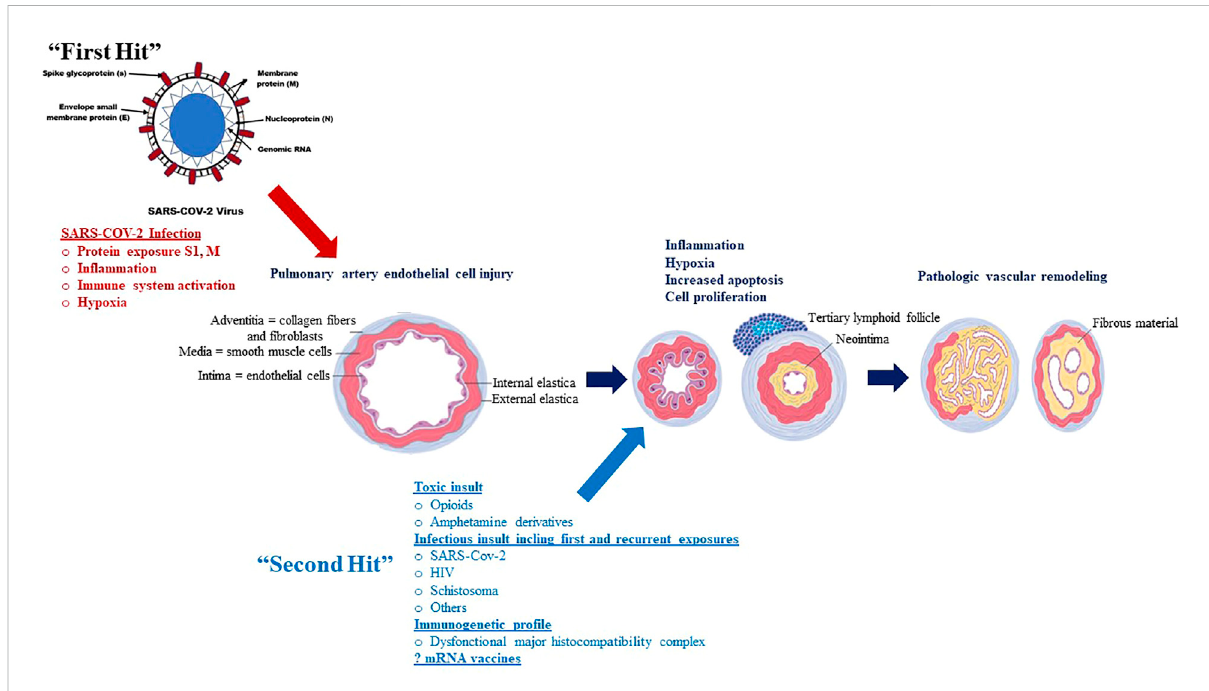
The potential association between SARS-COV-2 infection and PAH: A “ Multiple Hit ” Hypothesis (McLaughlin et al.,